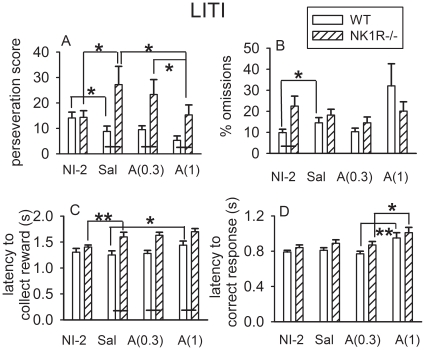
Effects of d-amphetamine on the behavior of wildtype and NK1R-/- mice tested with the LITI in the 5-CSRTT.The perseveration score of NK1R-/- mice is exacerbated by saline injection but ameliorated by d-amphetamine: the latter has no effect in the wildtypes (A). d-Amphetamine has no effect on % omissions in either genotype (B) but increases latency to reward in wildtypes (C) and latency to correct response (D) in both genotypes. Bars show mean ± s.e.m for the behavior of either untreated mice, tested for the second time with the LITI (NI-2), or mice given an i.p. injection of saline (Sal) or d-amphetamine (0.3 mg/kg, ‘A(0.3)’ or 1 mg/kg, ‘A(1)’). The mice experienced each treatment, once only, at weekly intervals. The sequence of treatments (including NI-2) was pseudo-randomised (latin-square) across the subjects. The black line linking adjacent bars indicates a genotype difference, regardless of time of day, of P<0.05, at least. N = 12 per group. * P<0.05, ** P<0.01, *** P<0.001 for comparisons of group means indicated above the bars.